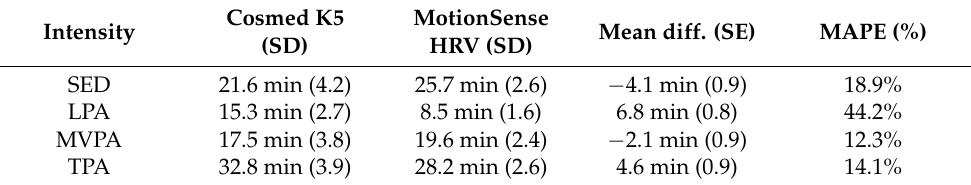
Table 3. Mean differences (SE) and Mean Absolute Percent Errors of Sedentary behavior and Physical activity (PA) between the GT9X and MotionSense HRV under free-living conditions. MotionSense Mean diff. (SE) MAPE (%) Intensity GT9X (SD) HRV (SD) SED 237.1 min (97.8) 242.8 min (99.5) − 5.7 min (1.7) 2.4% LPA 38.6 min (15.8) 35.3 min (14.8) 3.3 min (1.1) 8.7% MVPA 26.4 min (16.2) 24.0 min (15.1) 2.4 min (0.8) 9.1% TPA 65.0 min (29.3) 59.2 min (27.2) 5.7 min (1.7) 8.8%